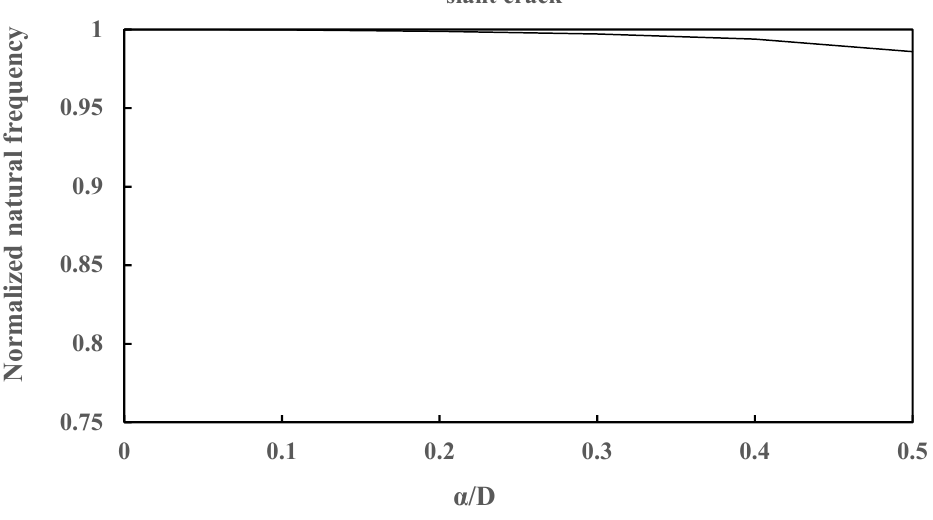
Figure 4. Normalised natural frequencies of a steel rotorbearing system with an open crack. Table 2. Normalised natural frequencies of a uniform rotor-bearing system for different crack depths.